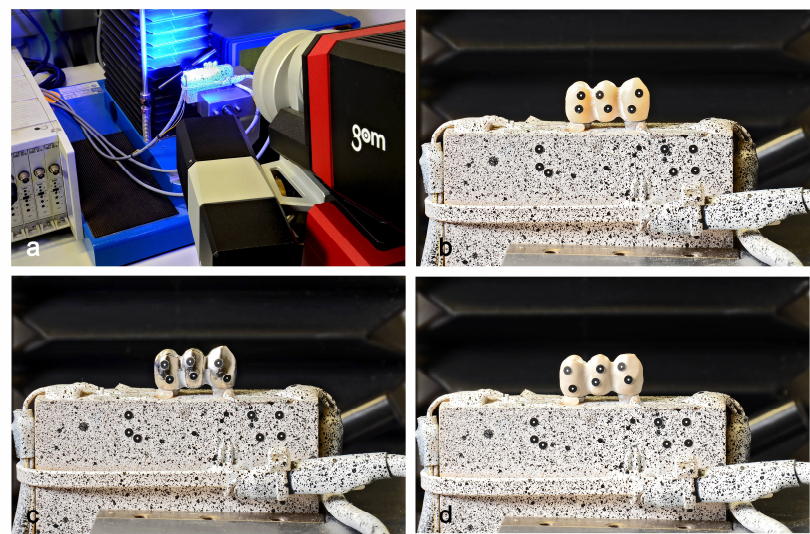
Figure 1. Experimental setup in long shot ( a ), artificial bone block with stochastic pattern and strain gauges as well as inserted implants and superstructure made of ceramics (zirconia) ( b ), artificial bone block with stochastic pattern and strain gauges as well as inserted implants and superstructure made of npm ( c ), artificial bone block with stochastic pattern and strain gauges as well as inserted implants and superstructure made of PEEK ( d ).